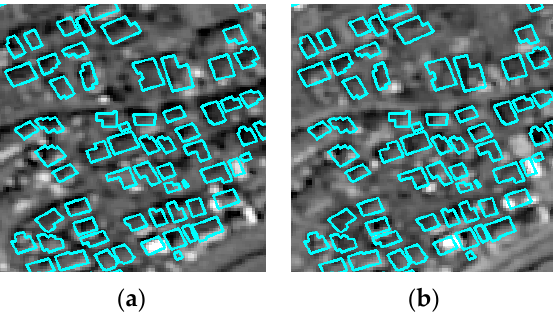
Figure 17. Examples of the estimation of a true negative (TN) by indicator ≤ 0.3 drawn in blue outline on a: ( a ) 20 March 2016 SPOT image; and ( b ) 25 March 2018 SPOT image.